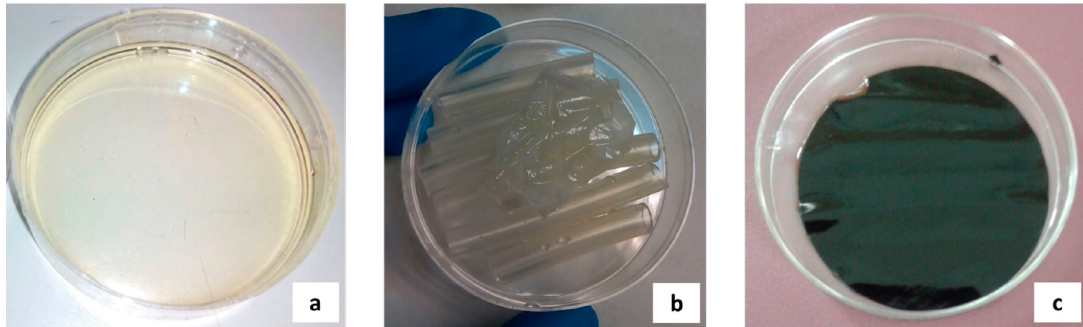
Figure 7. Identification of unstable SILMs with [EMIM]Ac: ( a ) PCTE in [EMIM]Ac (oven at 70 °C). ( b ) PCTE in [EMIM]Ac (oven at 30 °C). ( c ) HPVDF in [EMIM]Ac (oven at 70 °C).